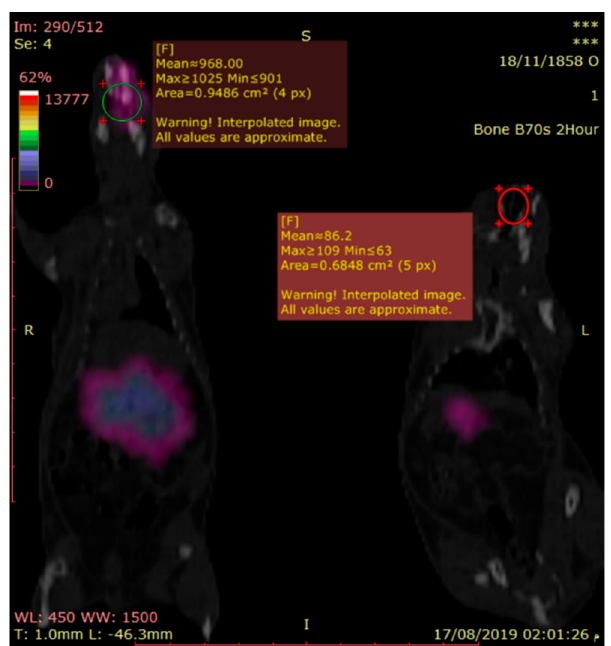
Figure 11. Sagittal view of fused SPECT/CT image of two rats, acquired after two hours of drug administration. The right one received 77.5 µCi of the oral Tc-99m labeled temazepam NLC-1 formulation; the left one received the same dose of the Tc-99m labeled temazepam oral suspension. Evidence of higher brain radioactivity is shown in the right one.